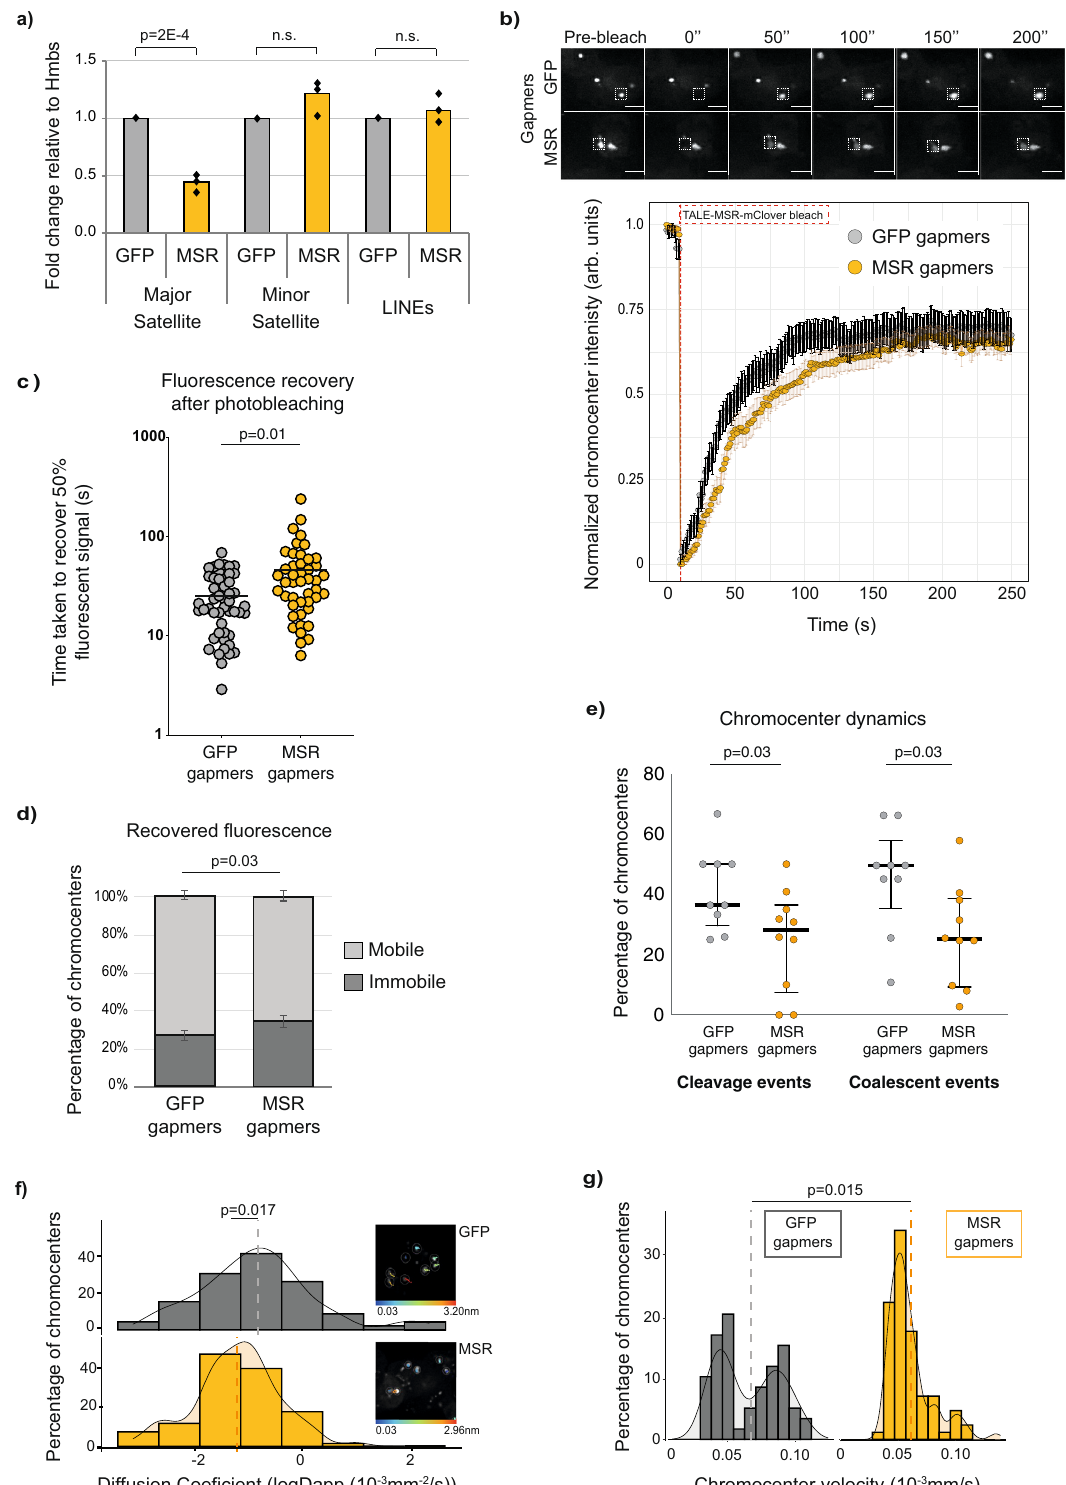
transcripts, TALE-MSR-mClover still localised to chromocenters, immediately after photo-bleaching was substantially slower in the as expected (Supplementary Fig. 2d). FRAP experiments revealed MSR RNA-depleted cells (Fig. 2b), which is consistent with the that the fl uorescence recovery time at photo-bleached chromo- TALE proteins being within a less dynamic chromatin 14 . In centers doubled in MSR RNA-depleted cells compared to agreement, the proportion of mobile TALE-MSR-mClover controls, indicating that the dynamic movement of TALE-MSR- slightly decreased in the MSR RNA-depleted cells (Fig. 2d), mClover molecules within chromocenters was reduced (Fig. 2b, c suggesting that MSR RNA levels affect the proportion of dynamic and Supplementary Movie 5). Notably, the fl uorescence recovery and stable components within chromocenters. Additionally, NATURE COMMUNICATIONS| (2022) 13:3525